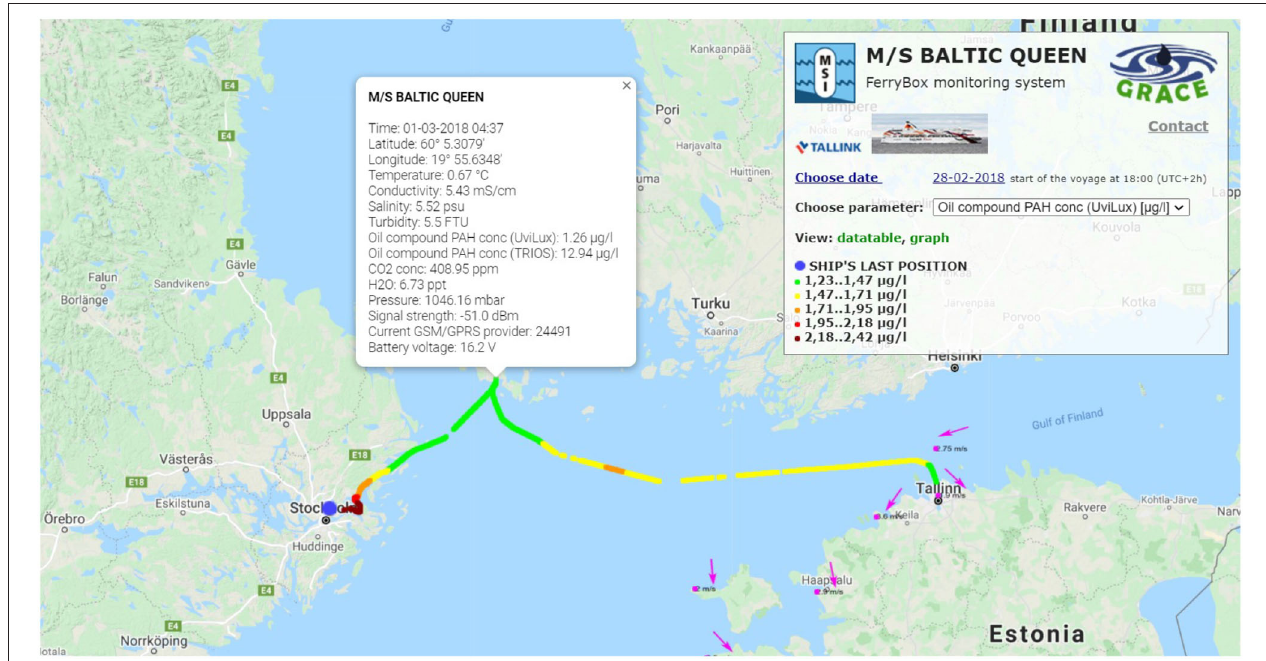
FIGURE 4 | Web-based user interface for viewing the real-time data from the FerryBox system (TalTech, 2017). The gaps in the data were caused by loss of the GSM-network.